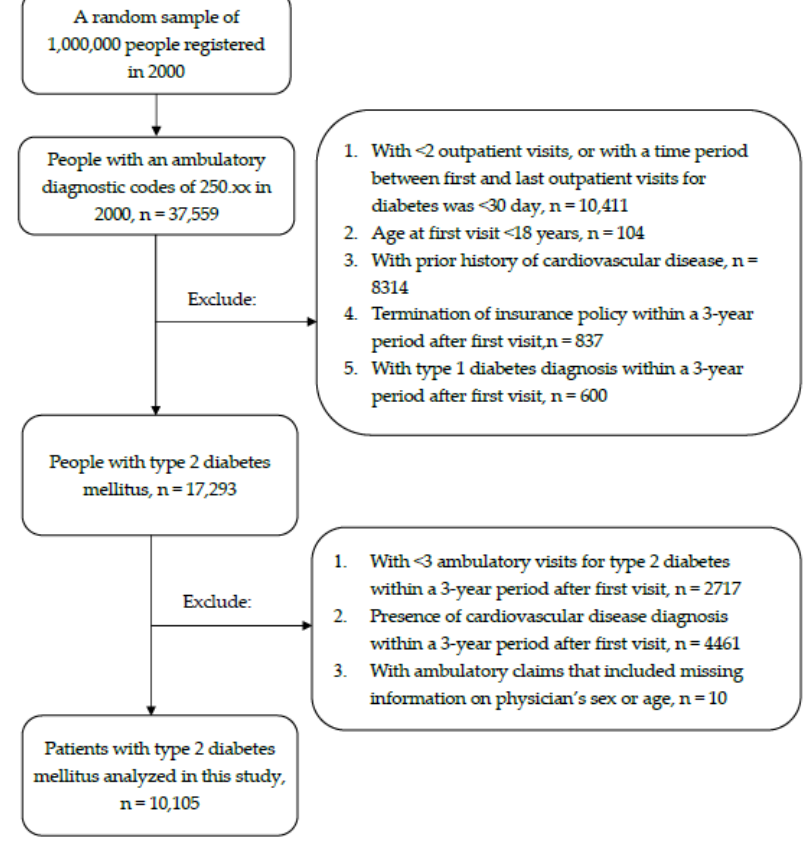
Figure 1. Flow chart of study subjects’ enrolment.